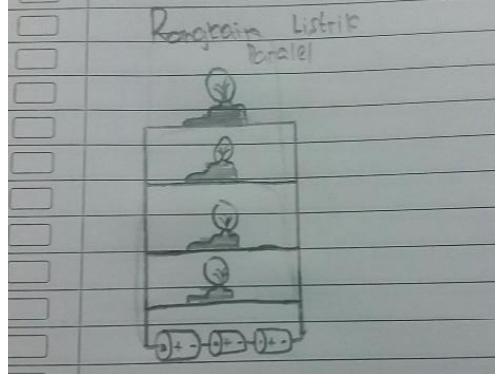
Figure 5 : One example of an image designed by students